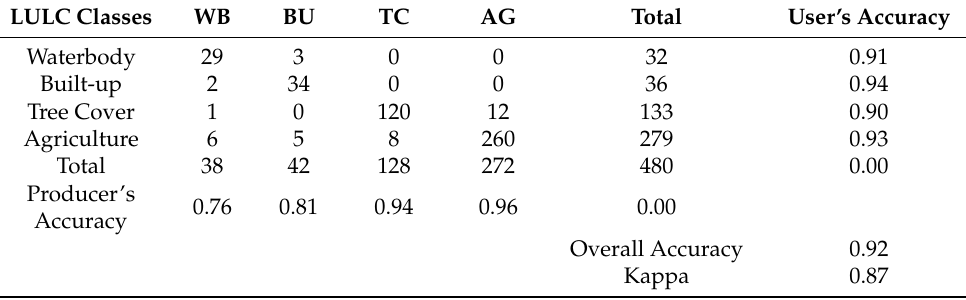
Table 6. Accuracy assessment of LULC of